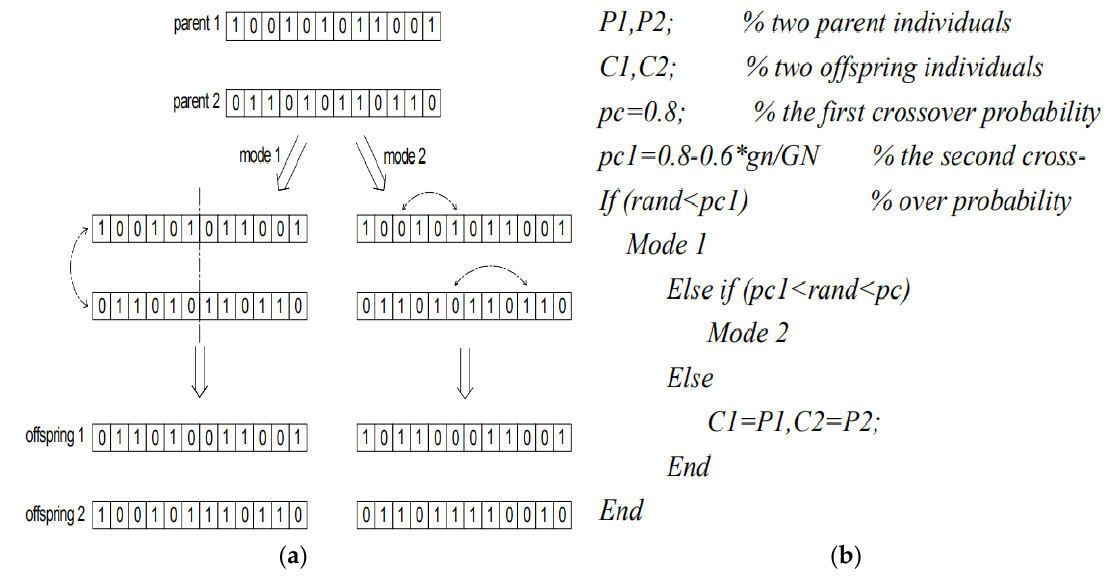
Figure 2. The crossover mechanism: ( a ) schematic diagram; ( b ) the pseudo-code.